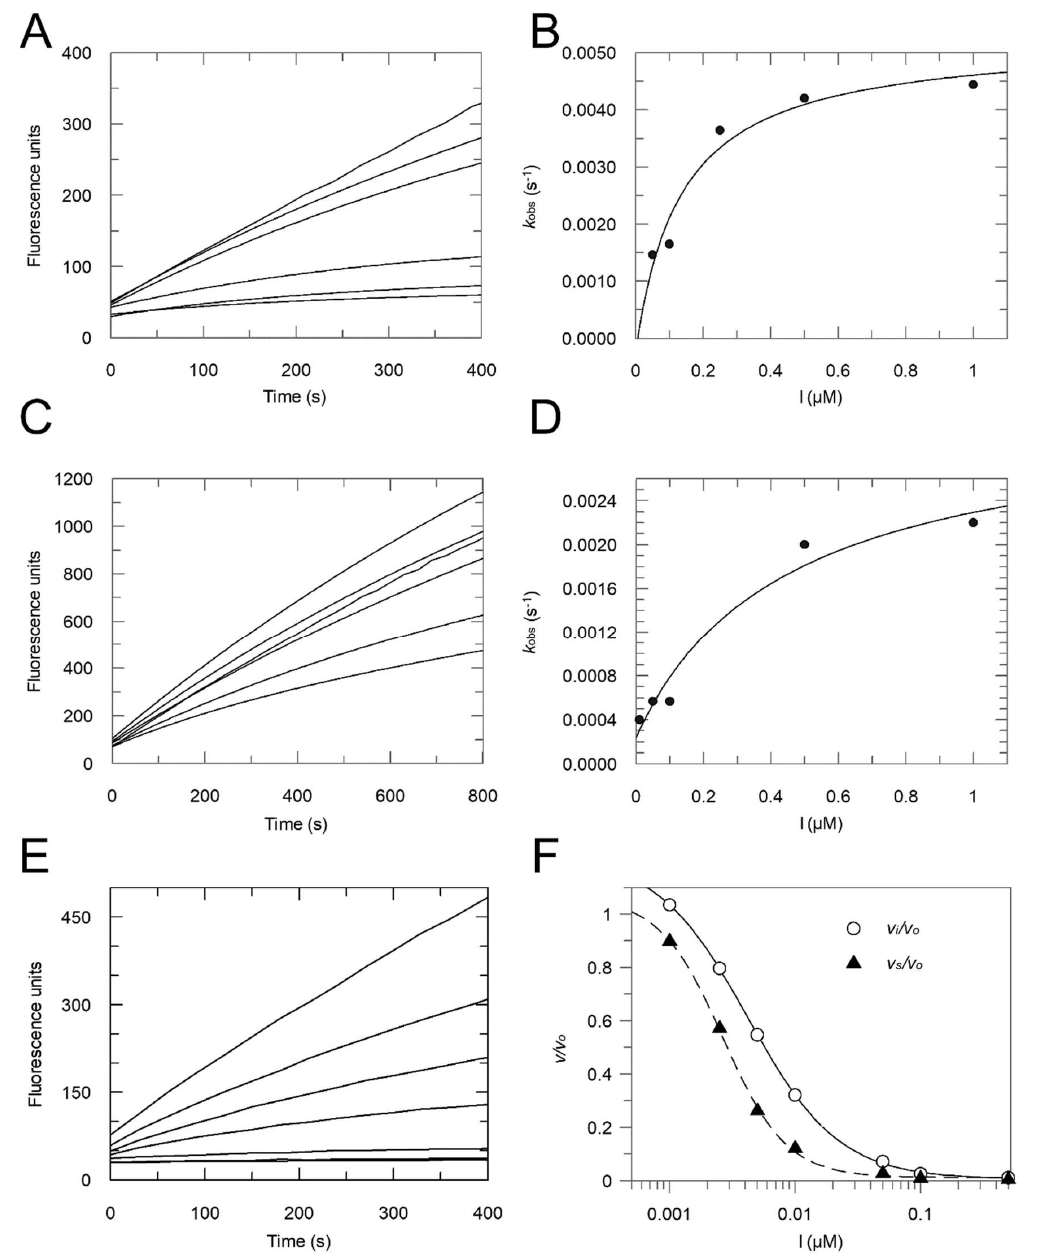
Figure 7. Inhibition of cathepsin L by compound 4 ( A , B ), rhodesain by compound 3 ( C, D ) and rhodesain by compound 4 ( E, F ). A , C, E: Progress curves with the following inhibitor concentrations (each from top to bottom): 0–0.05–0.1–0.25–0.5–1.0 µ M ( A ); 0–0.01–0.05–0.1–0.5–1.0 µ M ( C ) and 0.001– from Figure 7A ( → B ) and 7C ( → D ) as a function of inhibitor concentrations. The intercept with the y -axis provides an estimate of k 4 , while the maximum value of k obs at infinite inhibitor concentration reflects the sum of k 3 and k 4 . The concentration of inhibitor yielding a half-maximal value of k obs is equal to K iapp . F : Plot of the v i /v o and v S /v o values obtained from the progress curves of plot E as a function of inhibitor concentrations to yield K iapp and K i*app , respectively.